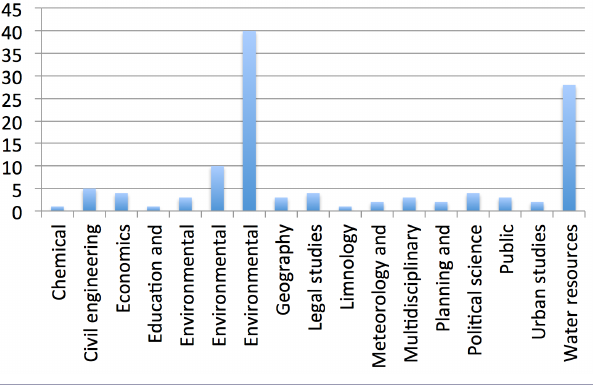
Fig. 3 . Number of publications by Web of Science